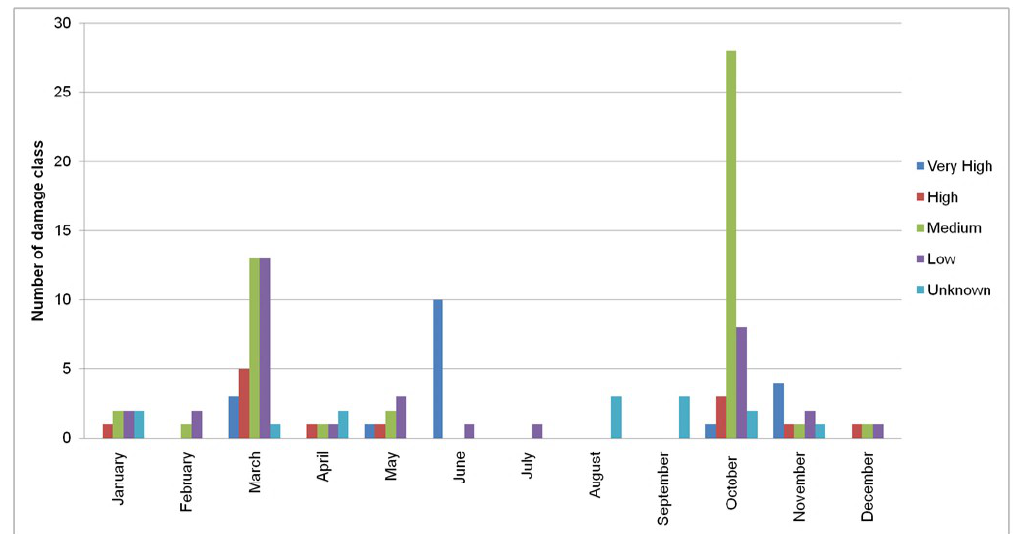
Figure 11. The monthly distribution of categories of damages during 1979–2010.